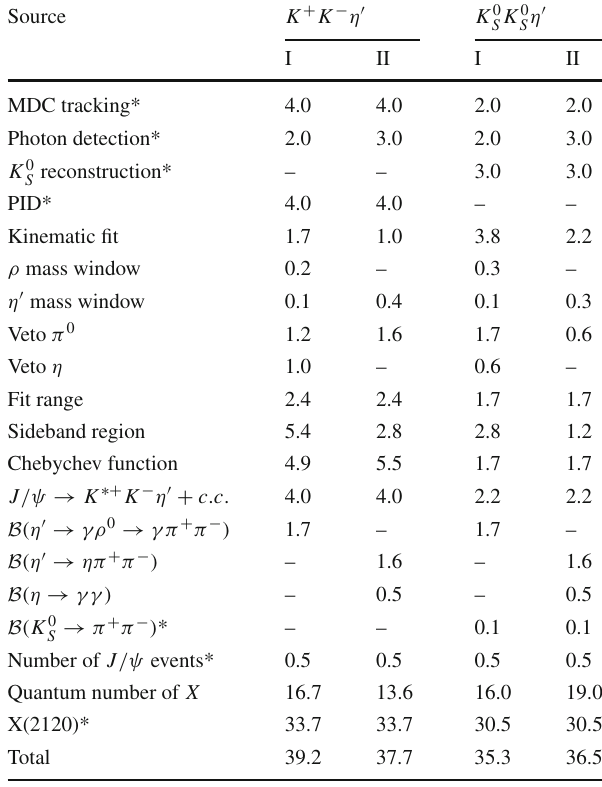
Table 4 Systematic uncertainties for determination of the branching fraction of J /ψ → γ X ( 2370 ) → γ K ¯ K η (cid:3) (in %). The items with * are common uncertainties of both η (cid:3) decay modes. I and II represent the decay modes of η (cid:3) → γρ 0 , ρ 0 → π + π − and η (cid:3) → π + π − η , η → γγ ,